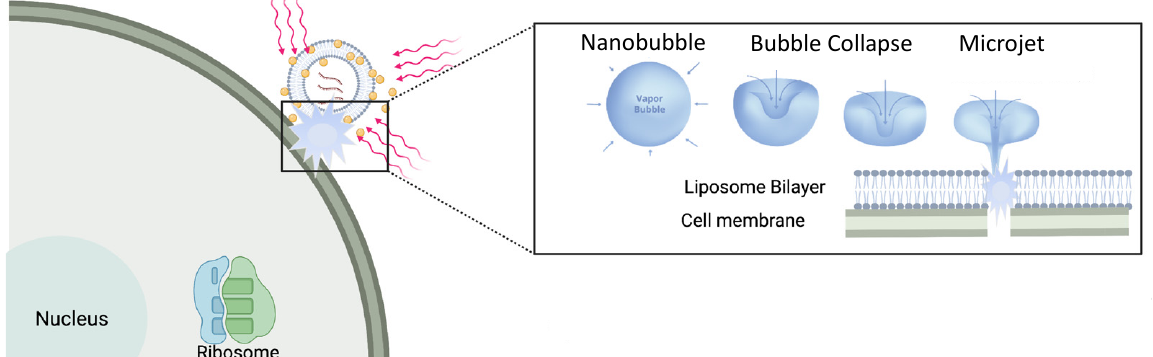
Figure 2. Plasmon-resonant gold nanoparticles tethered to liposomes can be triggered by short pulses of NIR laser light (red lines) that heat the nanoparticles. At a threshold light fluence, heat dissipating from the nanoparticles boils a minute amount of water to form unstable vapor nanobubbles that rapidly expand and contract. As the nanobubbles collapse, liquid–vapor microjets form that can perforate cell and liposome membranes. This allows the liposome contents to be rapidly released and cells to be perforated.